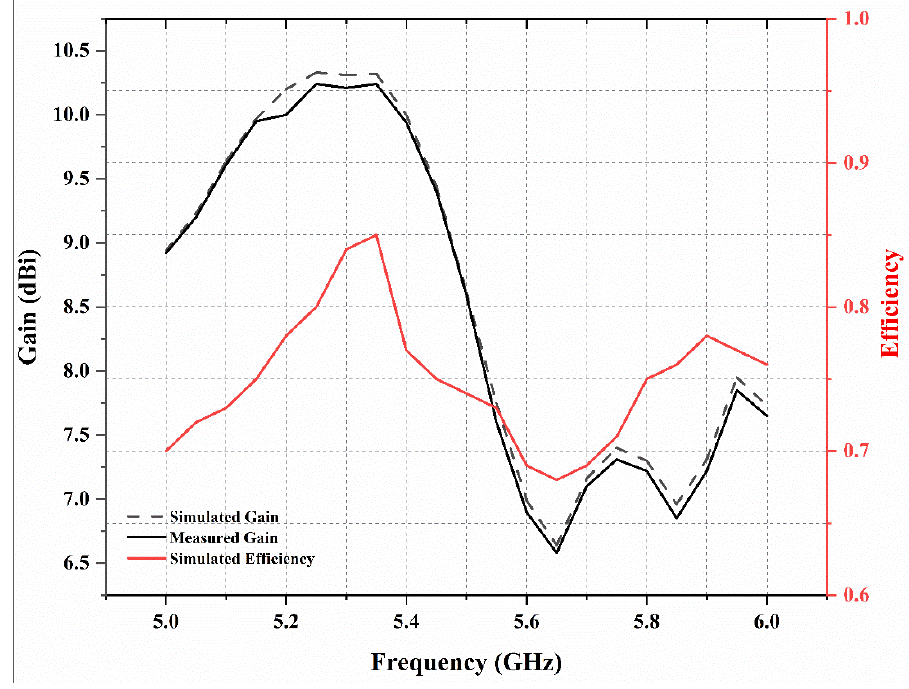
Figure 13. Simulated and measured gains and simulated total efficiency.